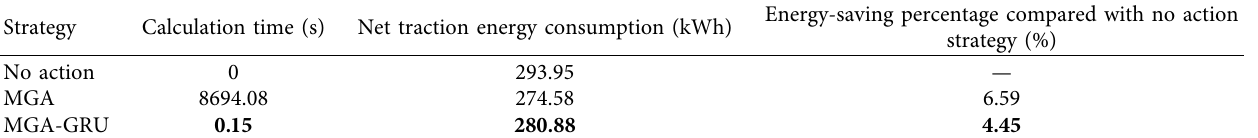
Table 5: Performances with three strategies in the two-train metro